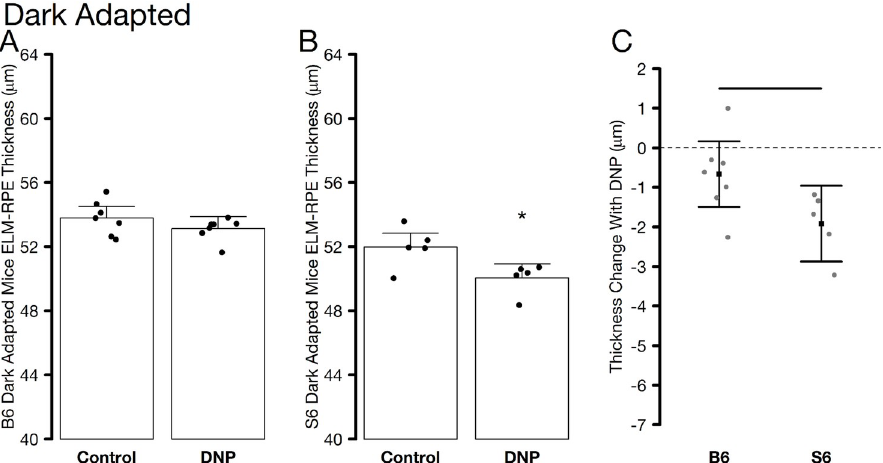
Fig 2. Summary of average ELM-RPE thickness measured from OCT images of dark-adapted control and DNP treated A) B6 and B) S6 mice. Individual data points (= number of eyes examined; one eye per mouse) represent the replicate average for each mouse to illustrate animal-to-animal variation. C) Paired differences to account for changes within mice; horizontal bar indicates significant differences between B6 and S6 groups. In all graphs, error bars represent 95% confidence